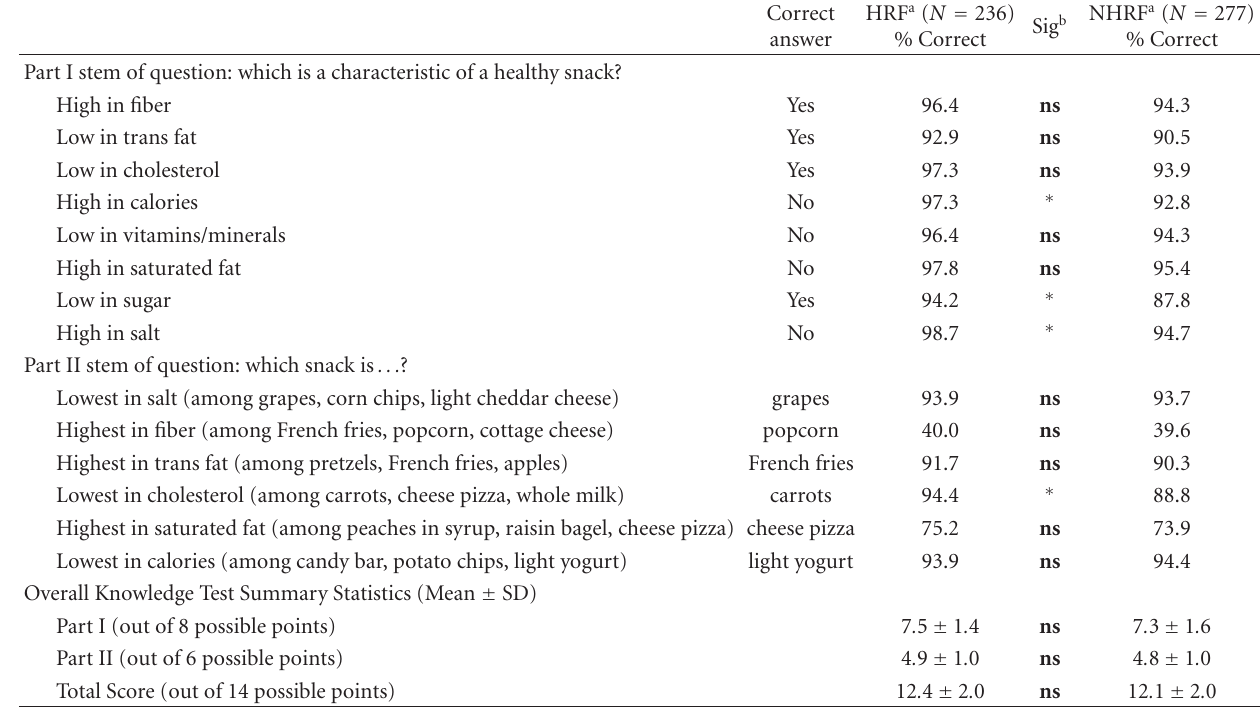
Table 3: Frequencies of correct and incorrect responses, and overall summary statistics, from 513 college undergraduates on the snack knowledge